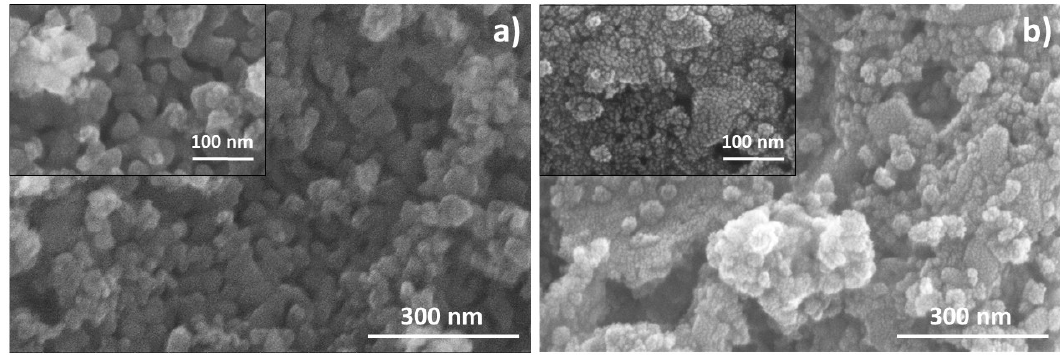
Figure 2. HR ‐ SEM micrographs of ( a ) SCNPTO and ( b ) SLTO powders. Figure 2. HR-SEM micrographs of ( a ) SCNPTO and ( b ) SLTO powders. Crystallite sizes (CSs) were obtained as estimated integral values for each peak posi ‐ tion using HighScore Plus (Philips’ program). Average CSs of about 27 nm and 33 nm were calculated for the SLTO and SCNPTO, respectively, and the data are graphically presented in Figure S2. It can be observed that CS possess slightly smaller values than particles size, as expected [47].